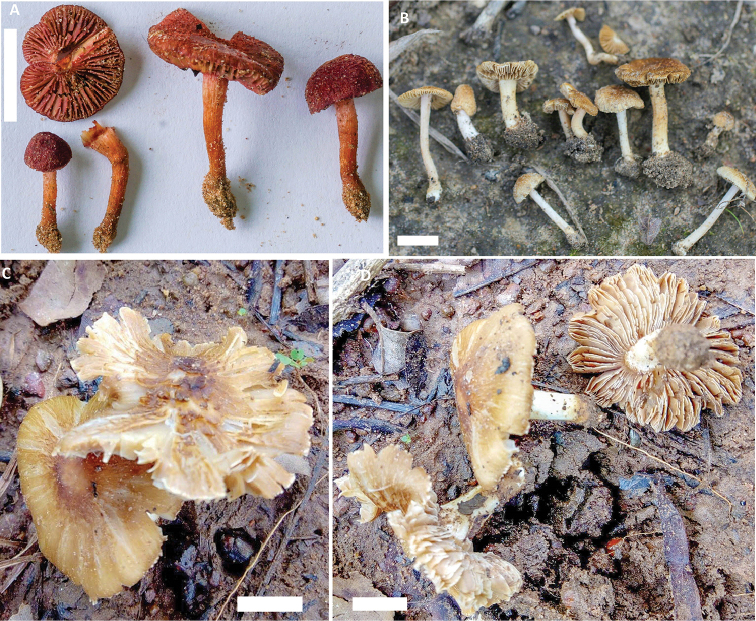
Macromorphology of: AInosperma
africanum (HLA0383) BInosperma
bulbomarginatum (MR00357) C, DInosperma
flavobrunneum (HLA0367). Scale bar: 1 cm.